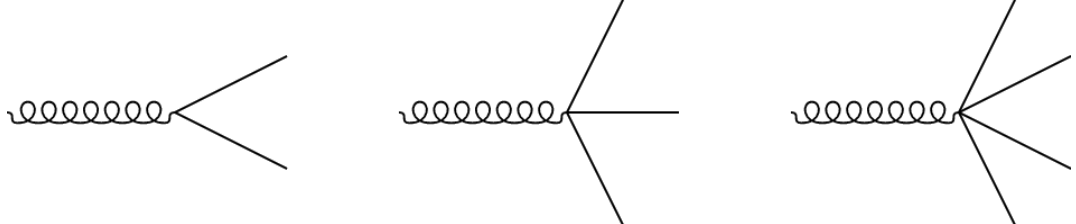
Figure 2 . The diagrams corresponding to the theories considered in this section. The straight lines represent matter, and the squiggly lines represent spin 2